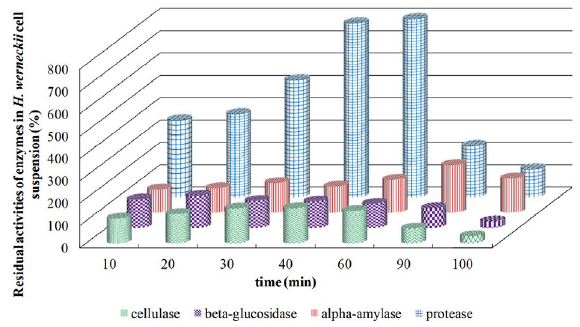
Figure 7: Residual activity of various enzymes in the H. werneckii cell suspension in relation to homogenization time at 35 °C and a homog- enization speed of 25,000 rpm. Experiments were repeated three times. Standard deviation for all measurements was less than ±